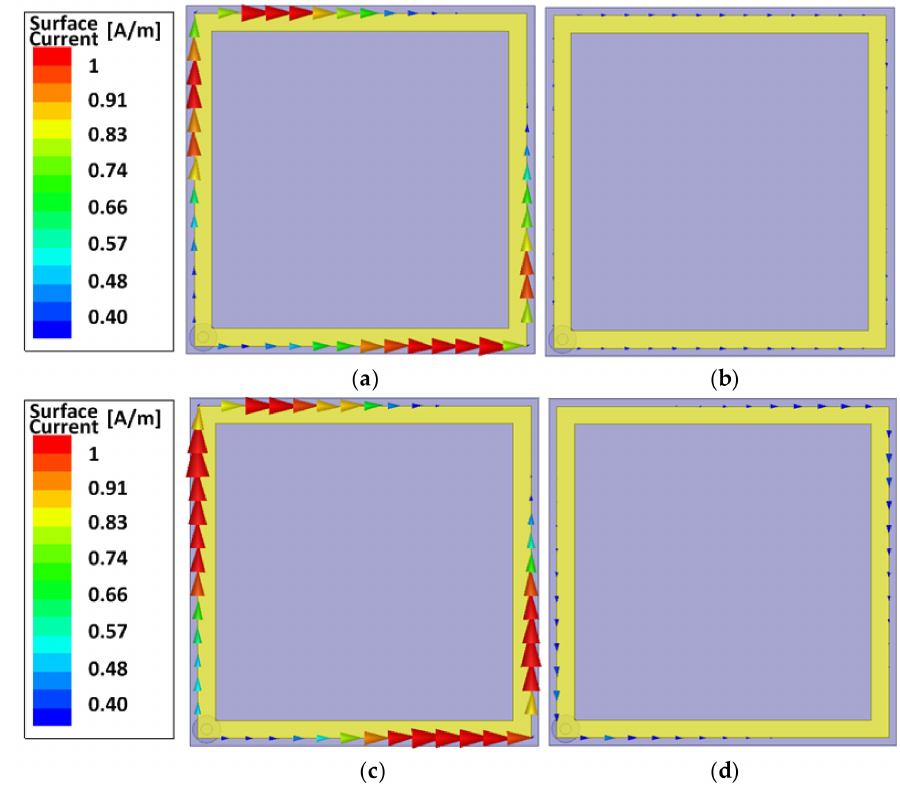
Figure 7. Simulated surface current distribution on the square-ring at ( a ) the resonant frequency of 2.5 GHz with TE polarization; ( b ) the non-resonant frequency of 2.2 GHz with TE polarization; ( c ) 2.5 GHz with TM polarization; and ( d ) 2.2 GHz with TM